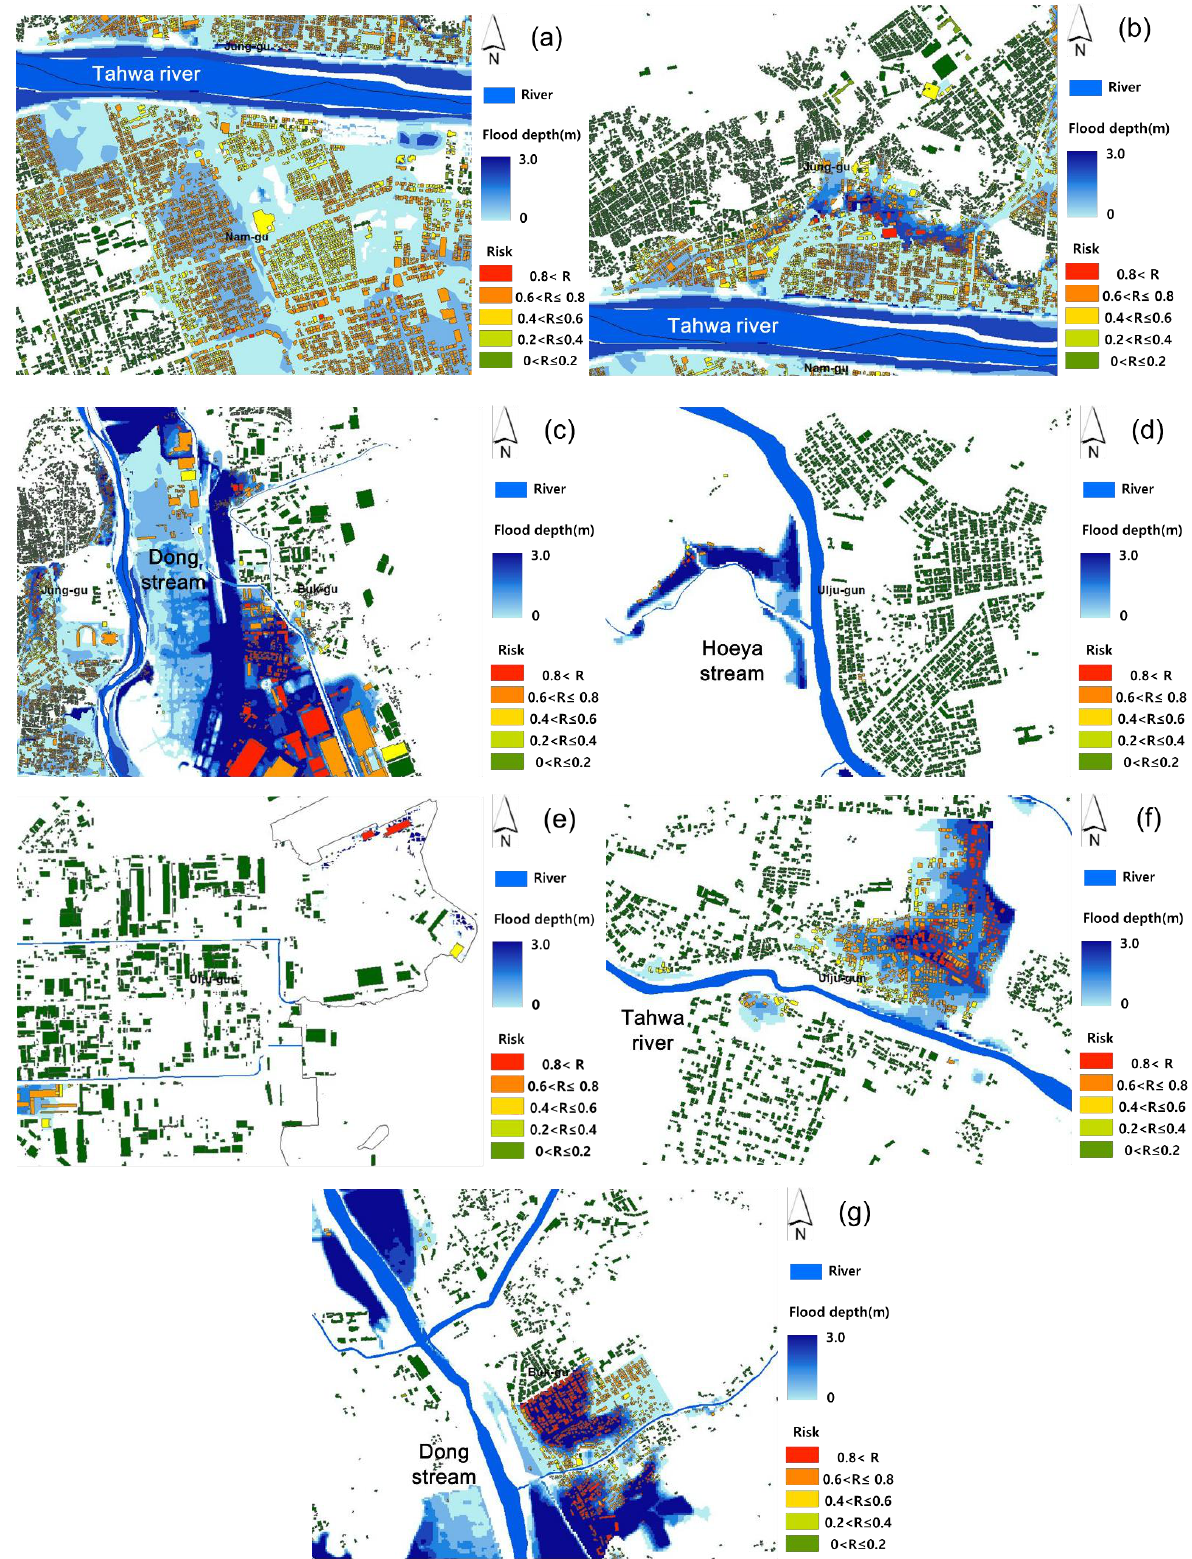
Figure 9. Micro view of classification by building on urban flood risk; Nam-gu district ( a ), Jung-gu district ( b ), South of the Buk-gu district ( c ), Buk-gu district near the stream ( d ), South of the Ulju-gun district ( e ), Ulju-gun district ( f ), North of the Buk-gu district ( g